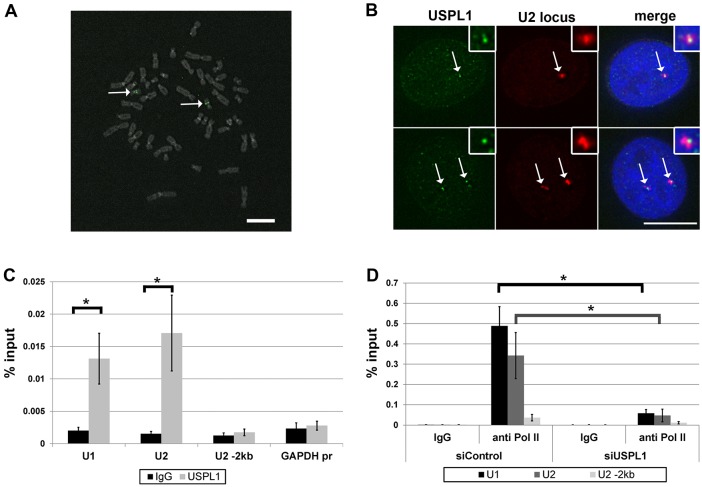
USPL1 is associated with U snRNA gene loci by DNA-FISH and ChIP. (A) Specificity of the probe for the U2 gene array (Cy5, shown in green; arrows) demonstrated on a metaphase spread from normal human male lymphocytes. (B) HeLa cells were subjected to DNA-FISH for the U2 gene locus (Cy5, shown in red) in combination with immunostaining for USPL1 (Alexa Fluor 488, shown in green). Arrows indicate nuclear foci containing both USPL1 and the U2 gene locus. Scale bars: 10 µm. (C) ChIP from HeLa cells using the USPL1 antibody is displayed in comparison to IgG control for the respective gene locus (U1, U2 or GAPDH). Bars represent the s.e.m. of six independent experiments, each analysed as technical replicate of two in the qPCR-reaction. Statistical significance was determined using an unpaired, heteroscedastic Student's t-test. (D) RNAPII occupancy detected by ChIP against the CTD of RNAPII (4H8 antibody) in comparison to IgG control for the respective gene region (U1, U2, U2 −2 kb) upon USPL1 knockdown. Bars represent the s.e.m. of four independent experiments, each analysed as technical replicate of two in the qPCR reaction. Statistical significance was determined using an unpaired, heteroscedastic Student's t-test. *P<0.05.